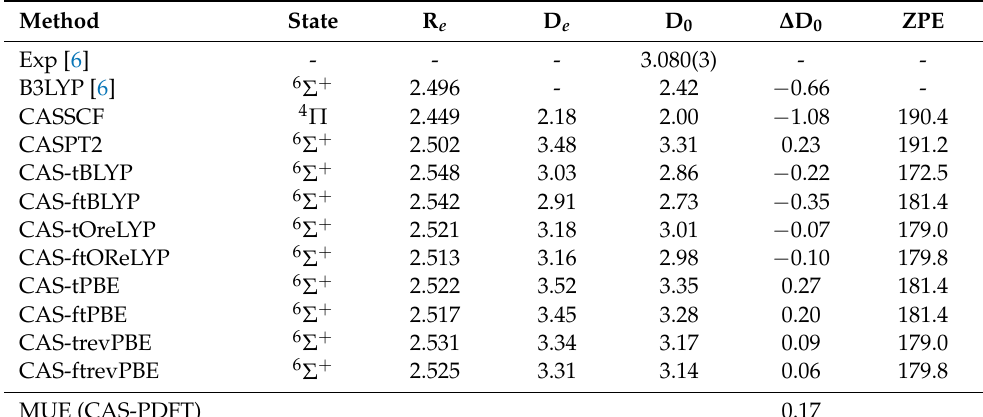
Table 8. Dissociation energies (eV), equilibrium bond lengths (Å), and zero point energies (in cm − 1 ) for NbSi in the ground state, computed with a CASSCF wave